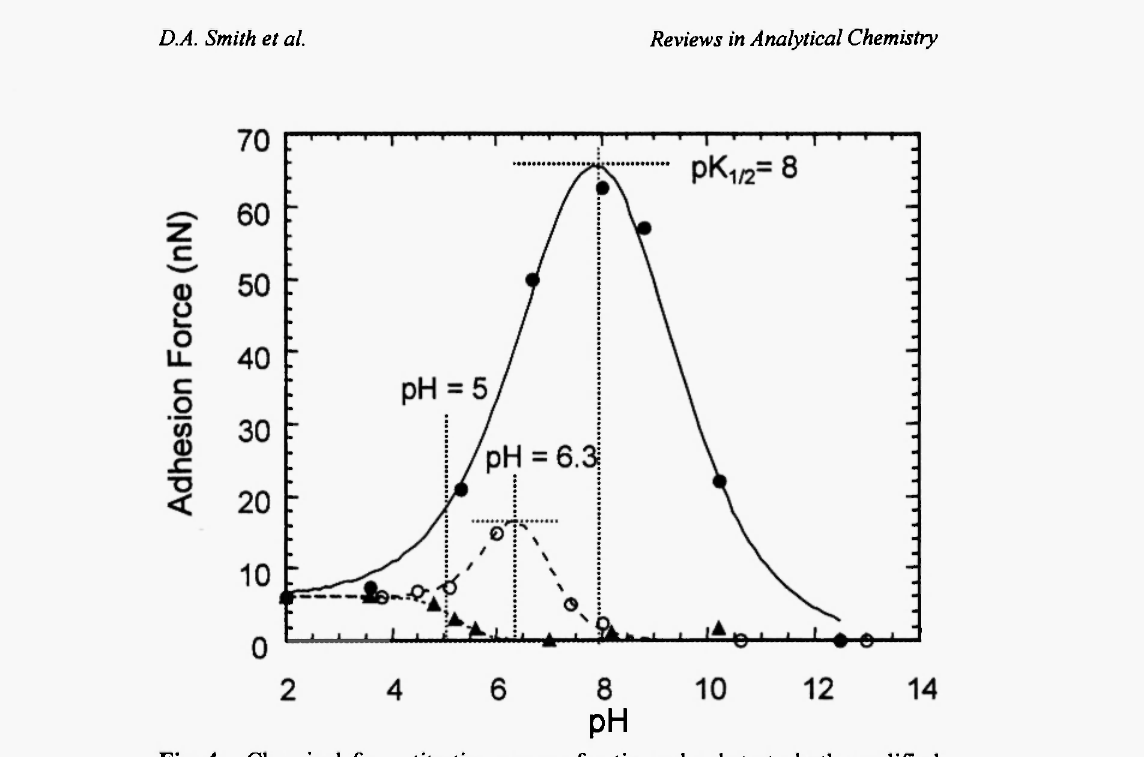
Fig. 4: Chemical force titration curves for tip and substrate both modified with 11-mercapto-undecanoic acid SAMs acquired at three electrolyte concentrations : low electrolyte concentration (~10 7 M, solid circles), intermediate electrolyte concentration, (ΙΟ 4 M, open circles) and high electrolyte concentration (10"'M, solid triangles). (The curves have been added only as a guide to the